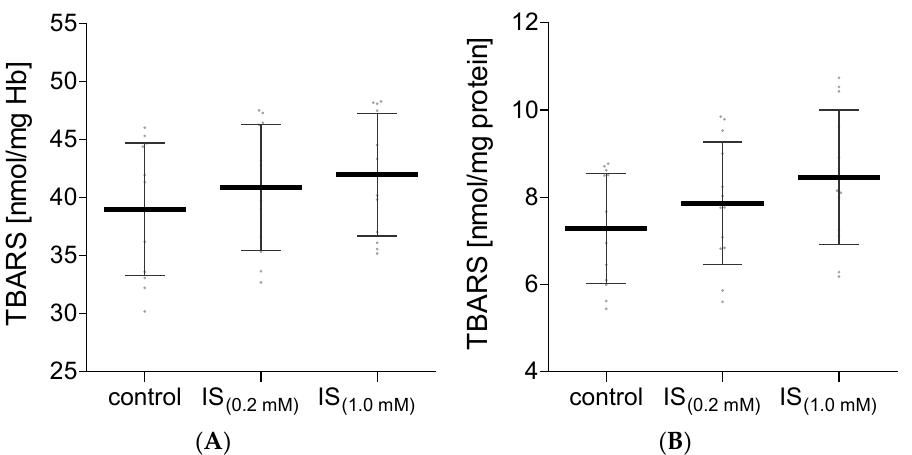
Figure 4. The levels of TBARS in hemolysate ( A ) and plasma ( B ) after incubation with IS. Data are expressed as mean ± standard deviation, n = 12. Gray spots: values of single results.